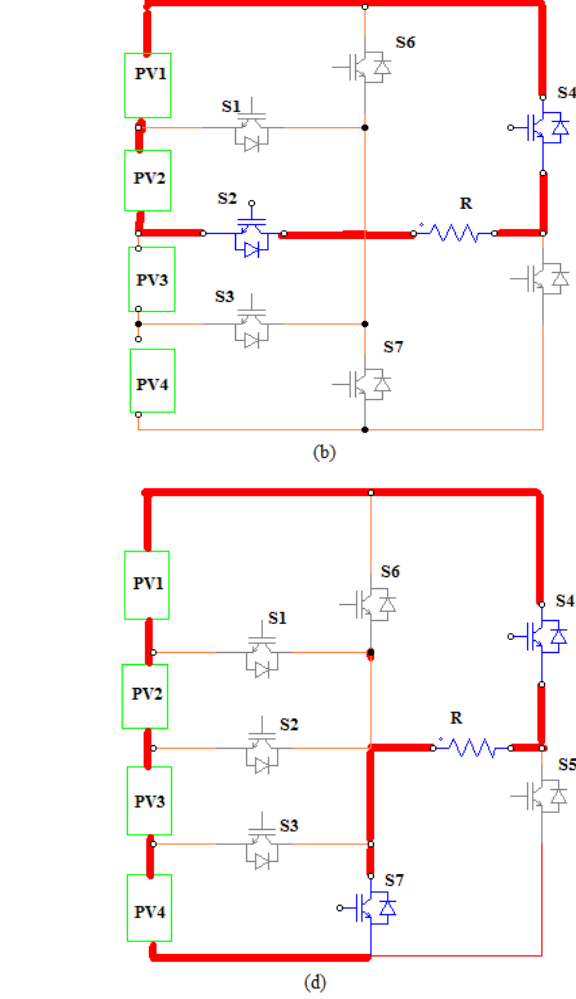
Figure 18 . Negative sequences for synthesizing the nine-level output voltage. ( a ) output voltage = − Vdc; ( b ) output voltage = − 2Vdc; ( c ) output voltage = − 3Vdc; ( d ) output voltage = − 4 Vdc.